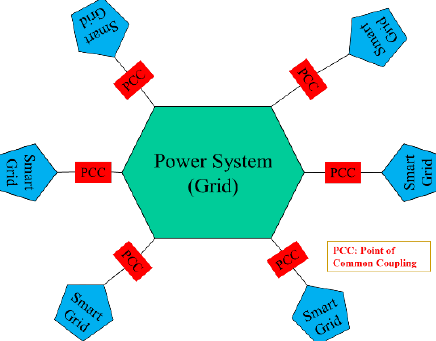
Figure 1. A Schematic of an Agile Power System.